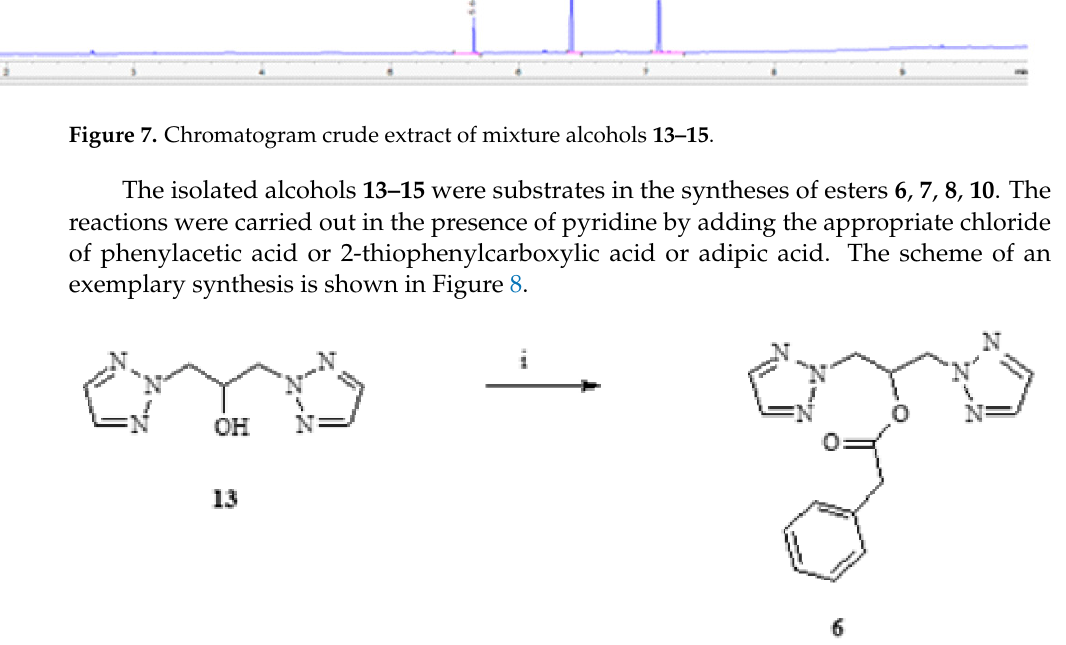
Figure 8. An example of ester synthesis. Scheme of synthesis of 1,3-di(1,2,3-triazol-2-yl) propan-2-